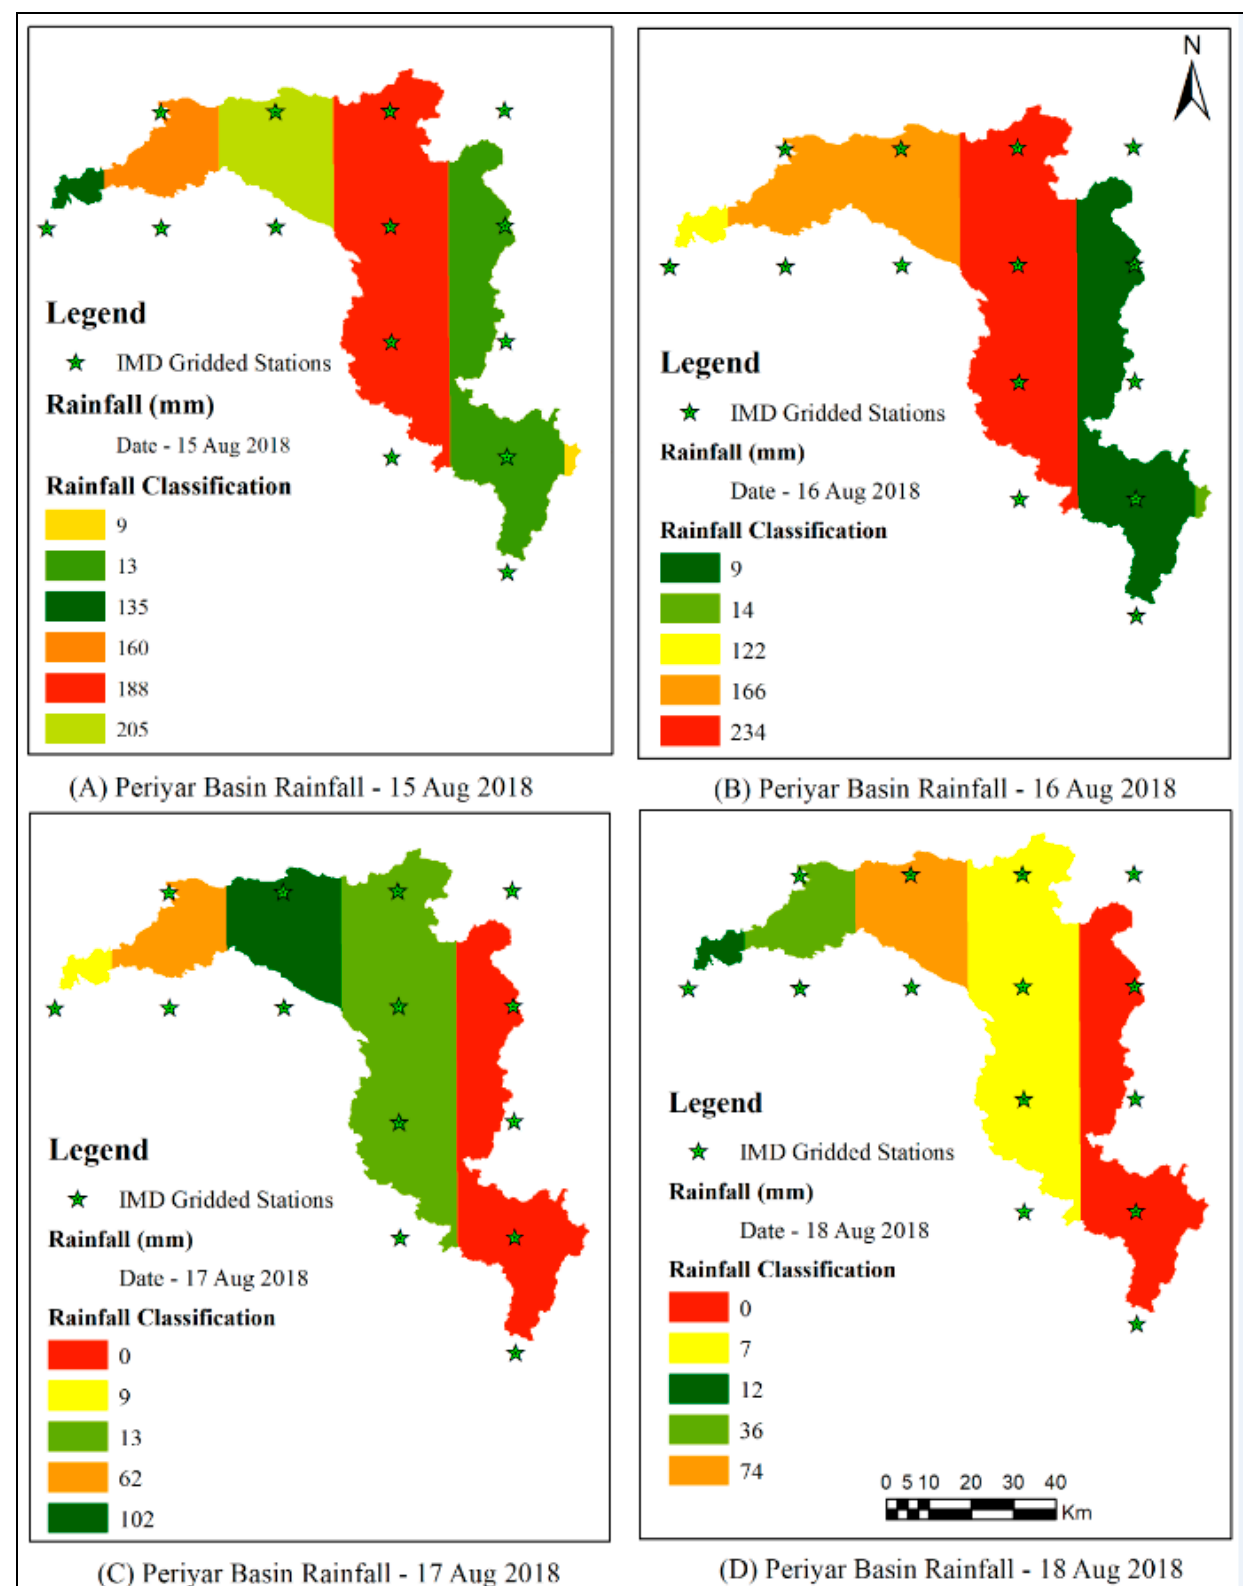
Figure 12. Rainfall analysis of Periyar river basin (15–18 August 2018).